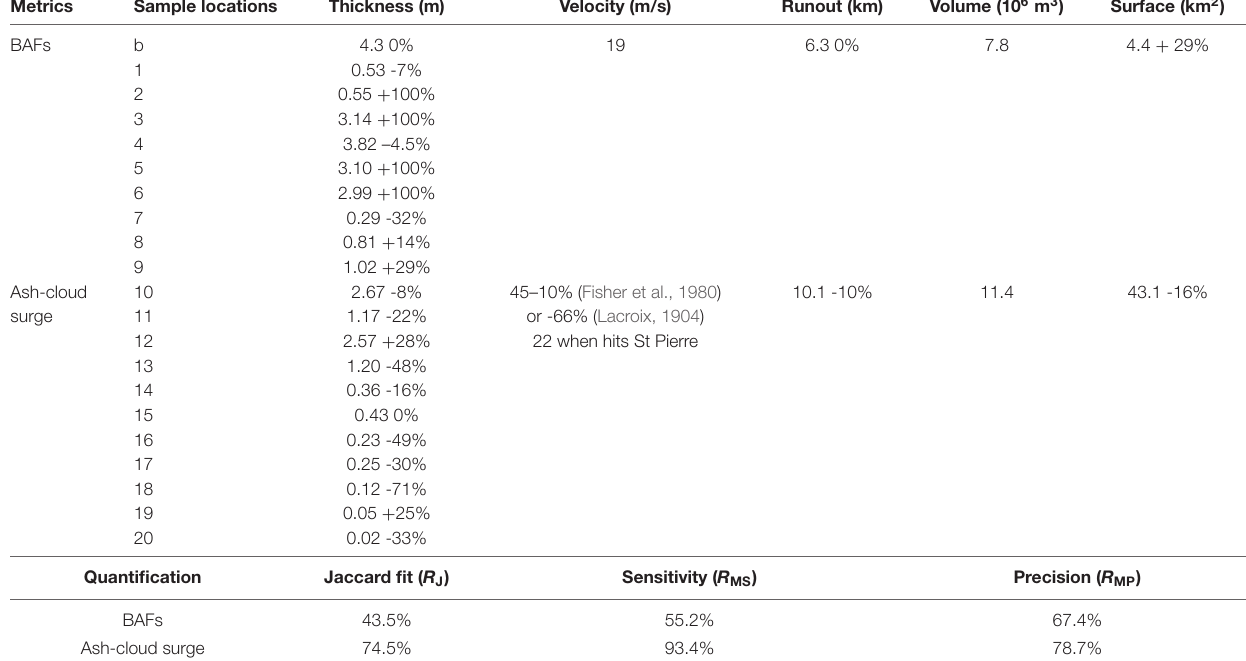
TABLE 3 | Values of validation metrics used for evaluating the best-fit simulation.